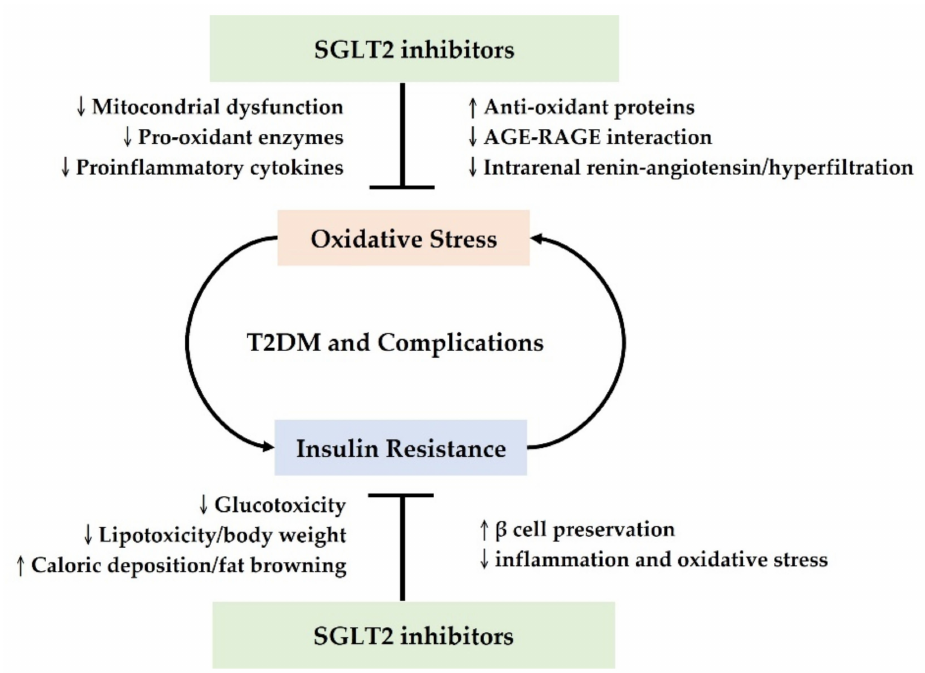
Figure 2. Schematic diagram presenting mechanisms via which SGLT2 inhibitors mediate antioxidant effects against T2DM and its complications. AGE, advanced glycation end product; RAGE, receptor for advanced glycation end product; SGLT2, Sodium-glucose cotransporter 2; T2DM, type 2 diabetes mellitus; ↑ , increase; ↓ , reduce. Table 1. Preclinical and clinical studies supporting the antioxidant roles of SGLT2 inhibitors in diabetes. SGLT2